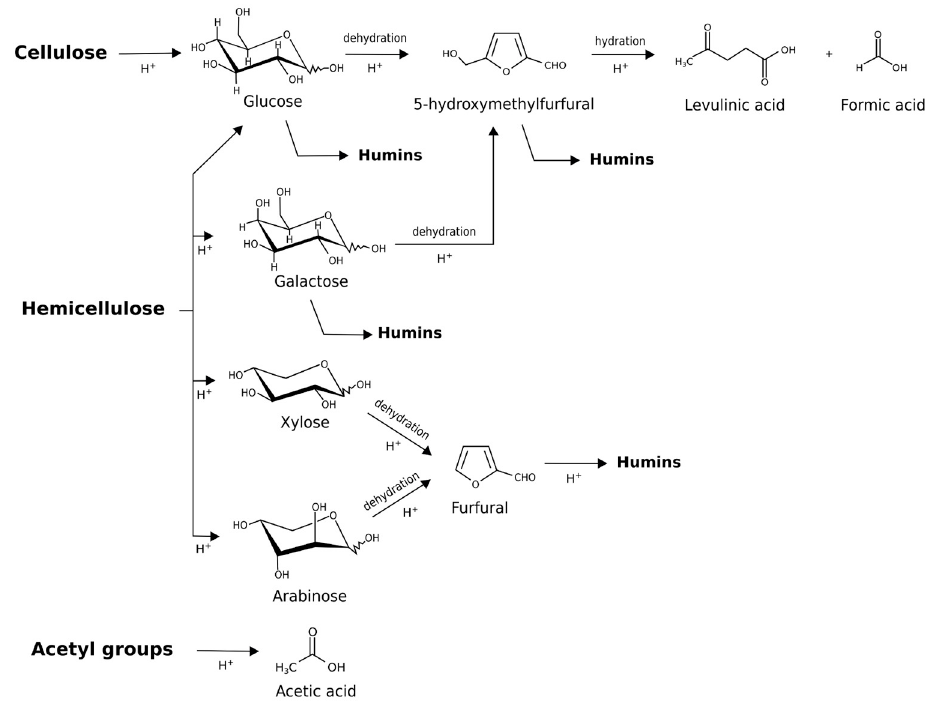
Figure 7. Simplified reaction network for the acid-catalyzed hydrolysis reaction of the water hyacinth plant [100].